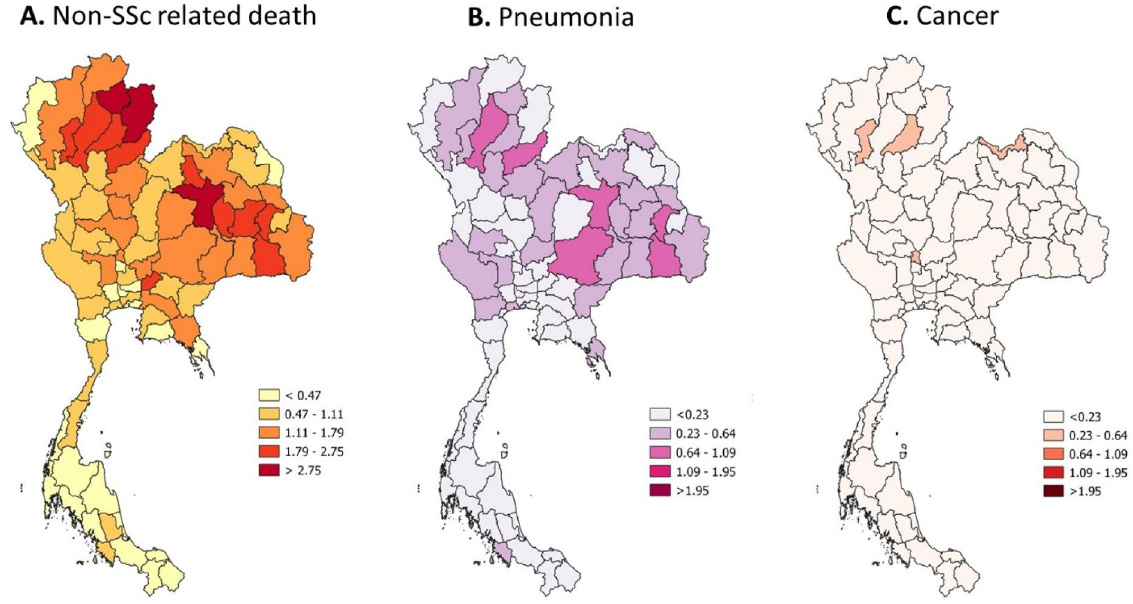
Figure 3. Incidence of non-SSc-related death stratified by province (per 100,000 dead cases) (QGIS software version 3.8.2: an open source and free software of geographic data system information was used for generating the maps; https:// www. qgis. org/ en/